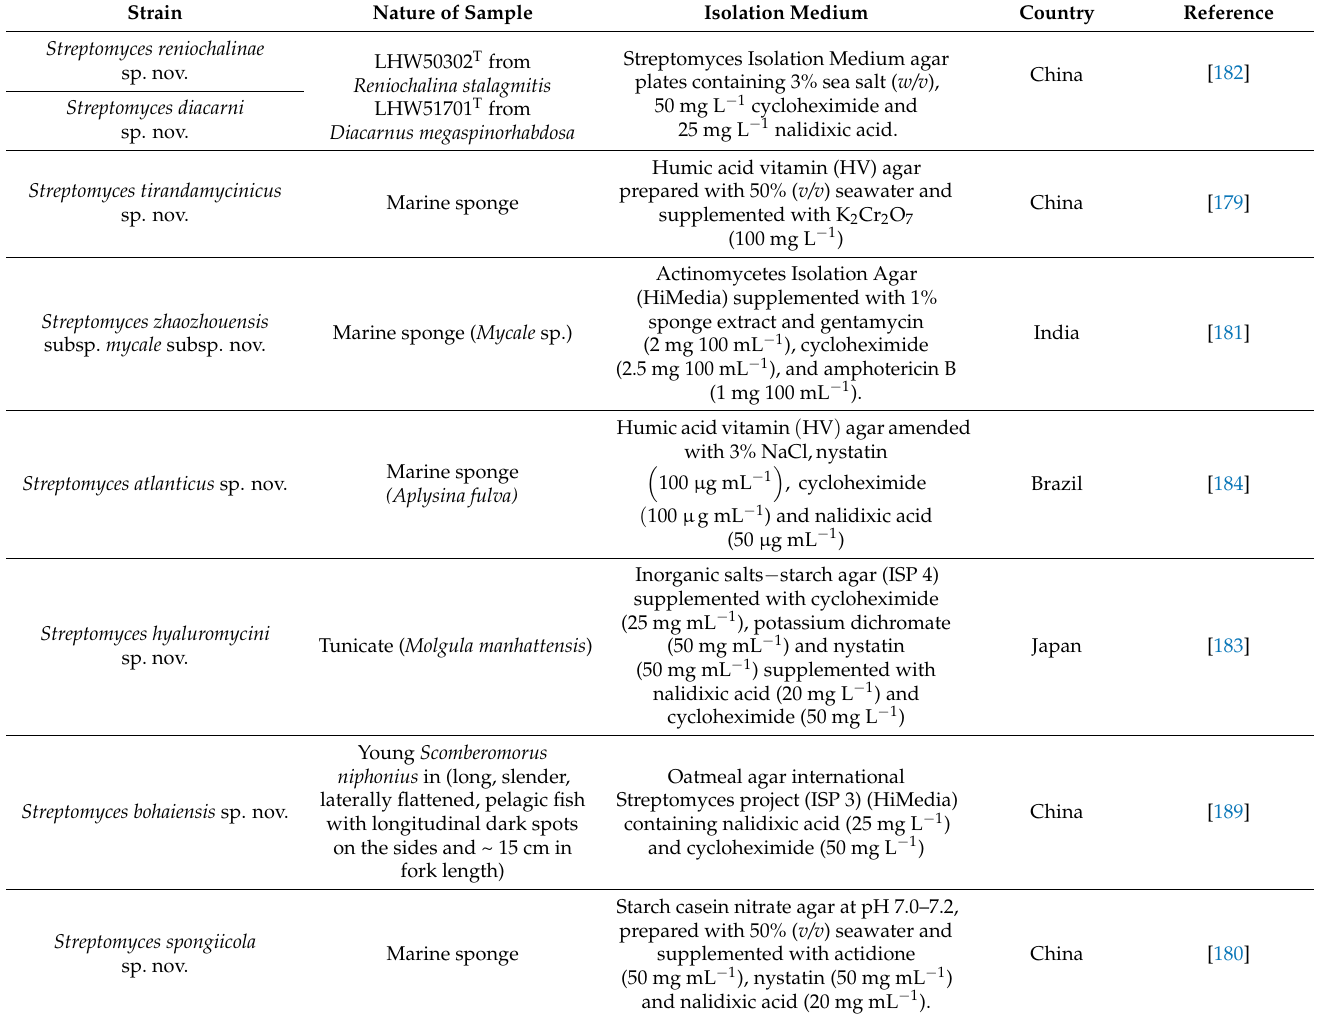
Table 6. Novel Streptomyces spp. reported from marine vertebrates and invertebrates between 2015 and